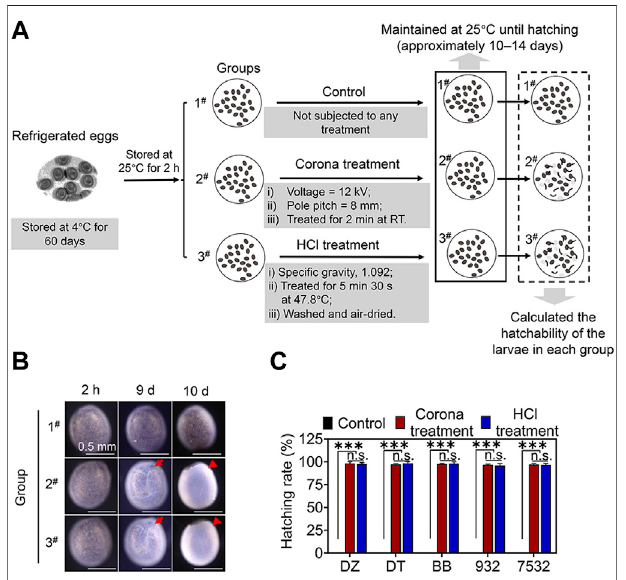
FIGURE 3 | Comparison of the effects of corona and HCl treatments in terminating the diapause of refrigerated eggs. (A) Schematic diagram of the experimental process of treating the refrigerated diapausing eggs under different conditions and comparing the larval hatchability. (B) Images of the refrigerated diapausing DZ eggs at different developmental stages from different treatment groups. Red arrows indicate the heads of larvae developing in the eggs; red triangles indicate the eggshells left by the larvae after hatching. (C) The hatching rates of larvae from the different treatment groups ofeach strain. Error bars represent onestandard deviation ( n =3; n.s., not signi fi cant; *** p < 0.001).